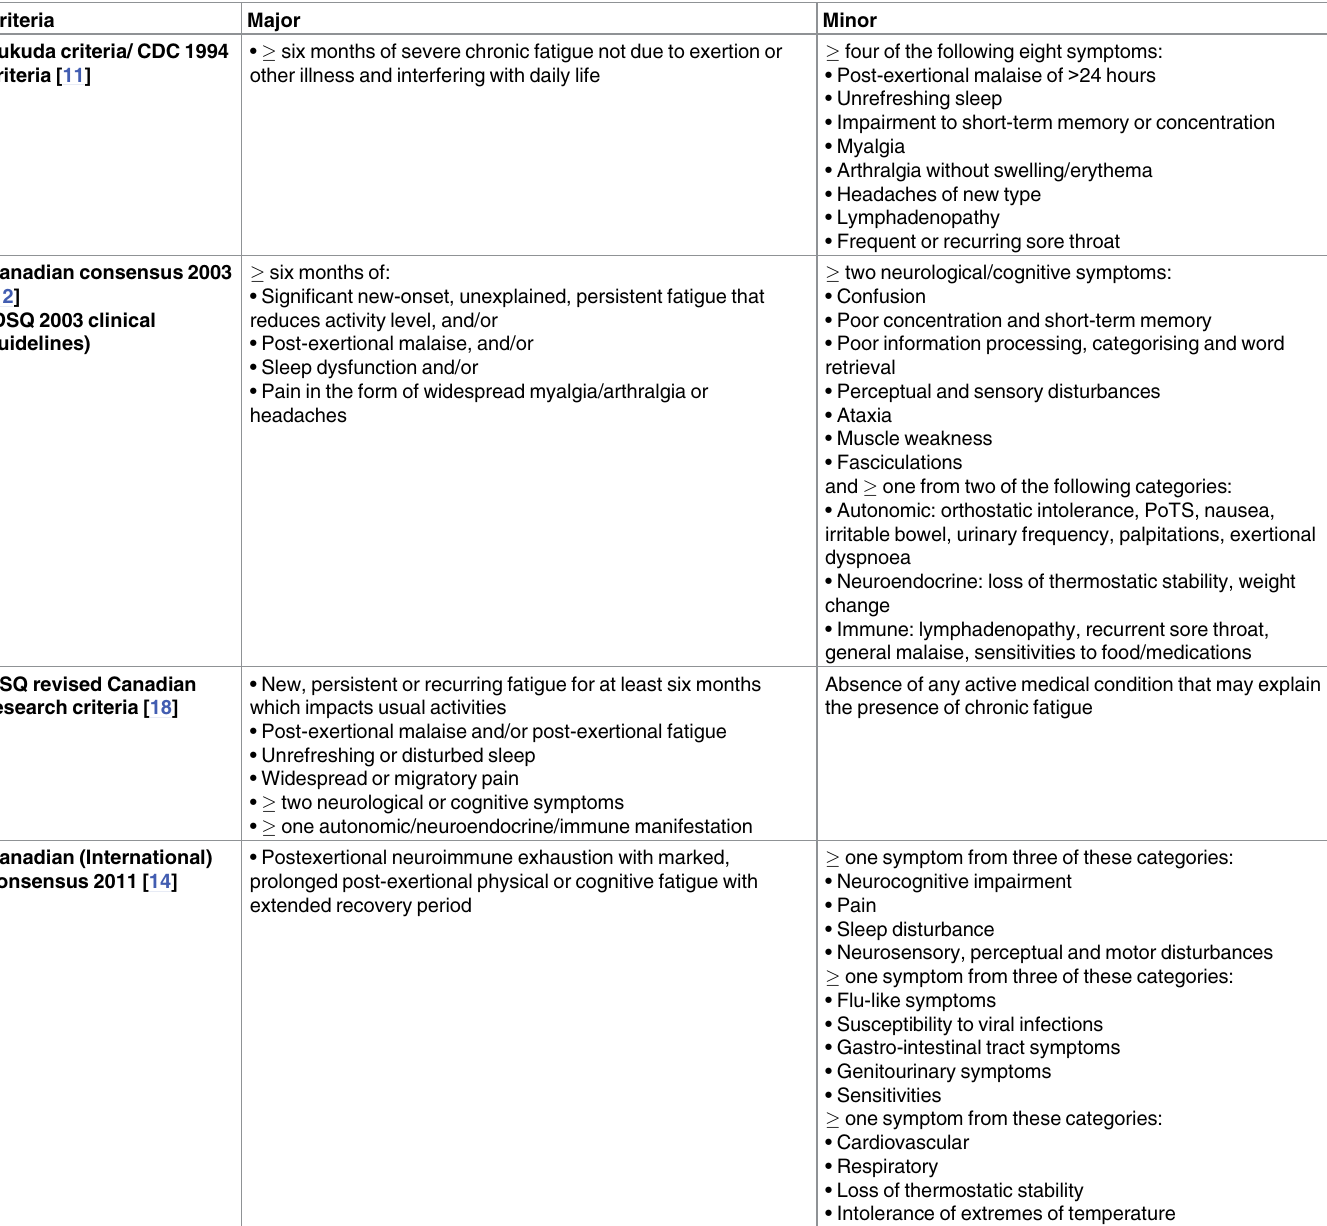
Table 1. Chronic fatigue syndrome diagnostic